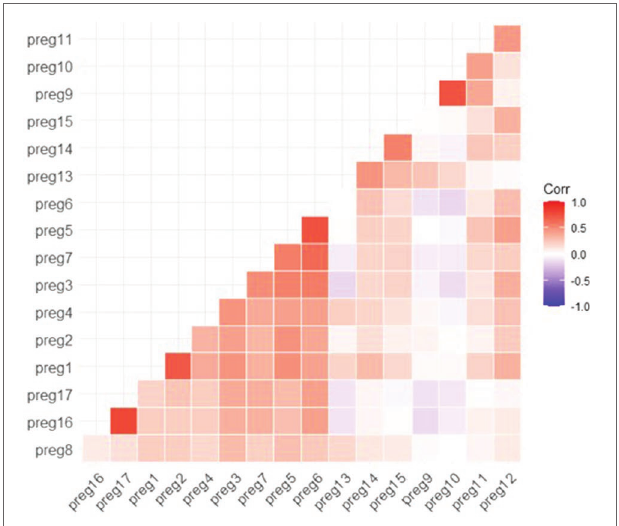
FIGURE 2 | Matrix of polychoric correlations for the knowledge and perception questionnaire of pesticide exposure for